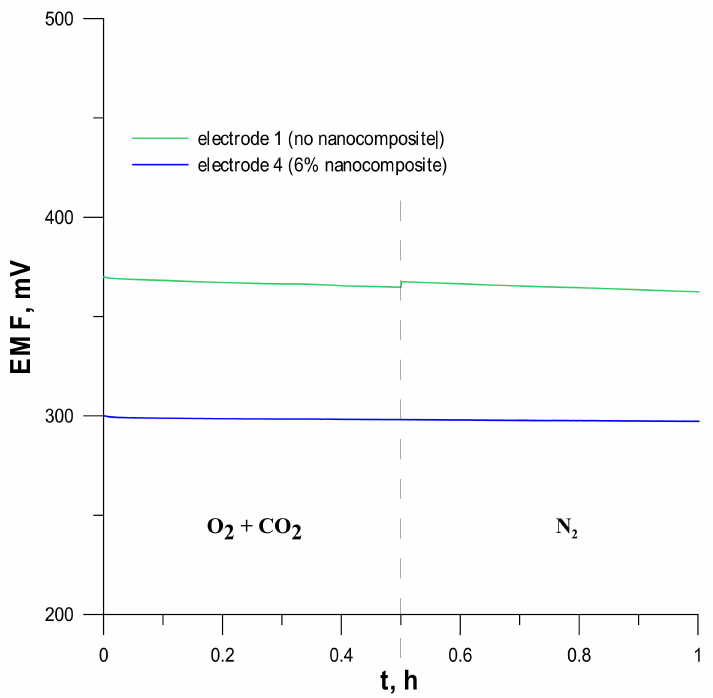
Figure 7. Influence of the presence of gases on the potential of the